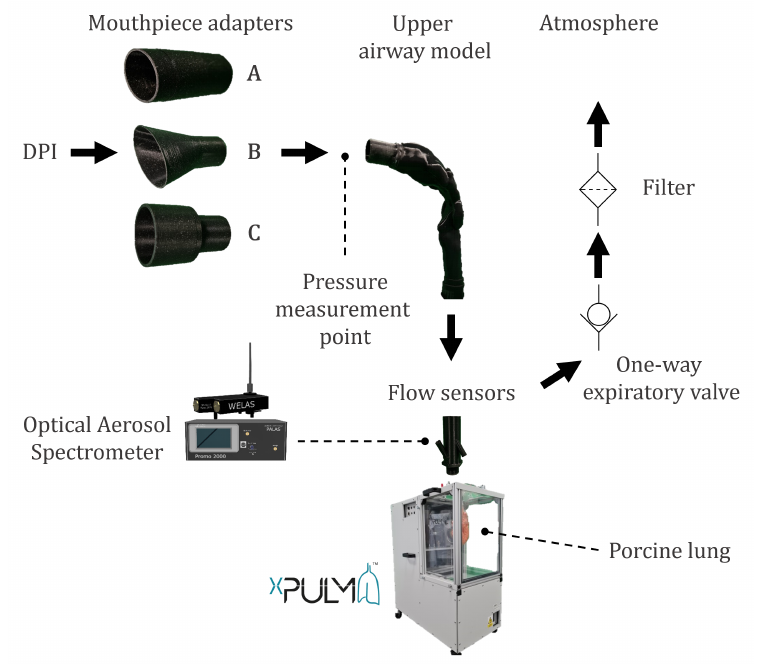
Figure 1. The measurement setup for respiration measurements consisting of mouthpiece adapters for (A) BreezHaler ® , (B) Ellipta ® , HandiHaler ® , (C) Turbohaler ® , the mechanical UAM derived from CT examinations, and the optical aerosol spectrometer used to characterize the aerosol particles and the active model of the human respiratory system xPULM™ with the porcine